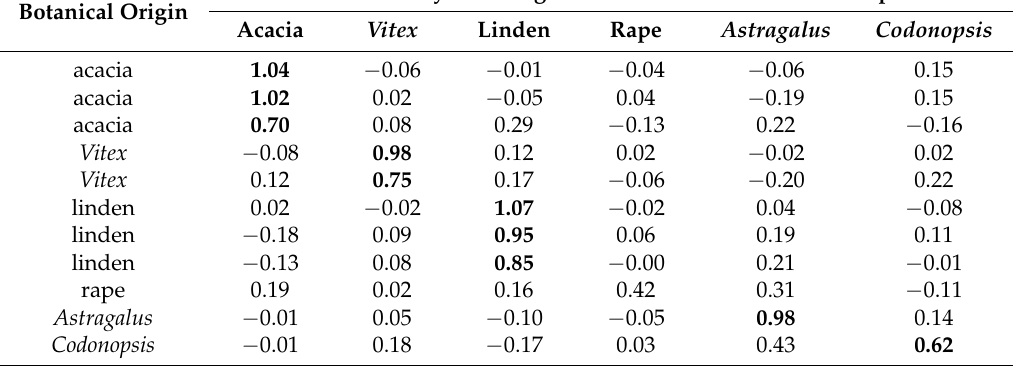
Table 6. Classification list for prediction based on the PLS-DA models performed by considering the training set